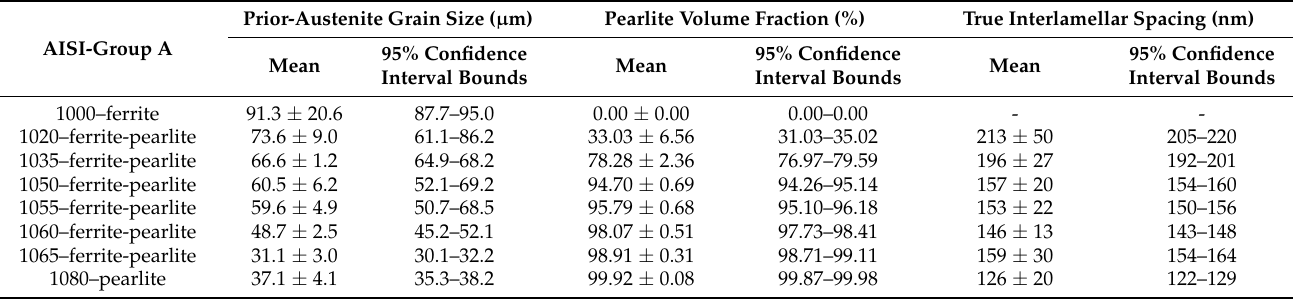
Table 2. Average prior-austenite grain size, pearlite volume fraction and true interlamellar spacing values of samples of group